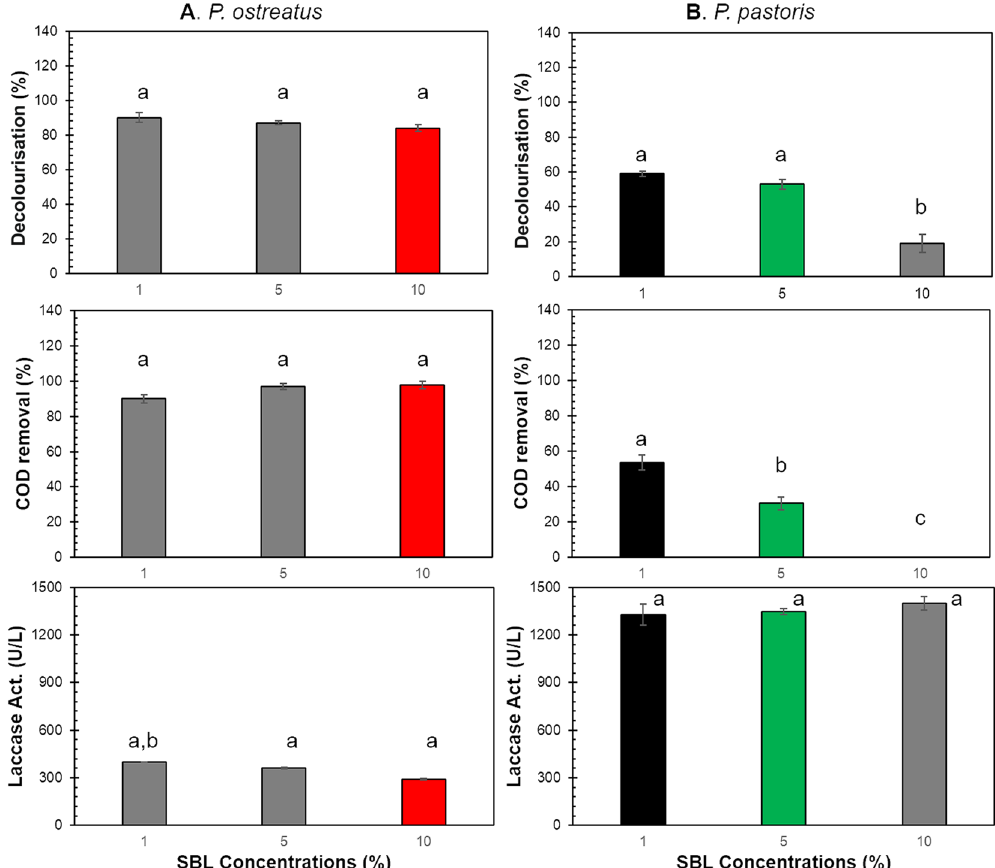
Figure 1. Effect of synthetic black liquor concentration on the removal capacity of P. ostreatus and P. pastoris . SBL percentages of 1, 5, and 10% (v/v) were evaluated. ( A ). Experiment with P. ostreatus . Decolourisation percentages of 90, 87, and 84% (v/v) were observed for 1, 5, and 10% (v/v) SBL, respectively. COD removal values of 90, 97, and 98% were determined for 1, 5, and 10% (v/v) SBL, respectively. Laccase activity ranged between 290 UL − 1 to 400 UL − 1 for all evaluated concentrations. ( B ) Experiment with P. pastoris . Decolourisation percentages of 59, 53, and 19% (v/v) were observed for 1, 5, and 10% (v/v) SBL, respectively. COD removal values of 53, 30, and 5% were determined for 1, 5, and 10% (v/v) SBL, respectively. The laccase activities for the three concentrations evaluated were 1,327, 1,346, and 1,399 UL − 1 . The letters a,b, and c represent Tukey homogeneous subsets. The letter a corresponds to the best result, followed in order by b and c. Mean ± SD (n =